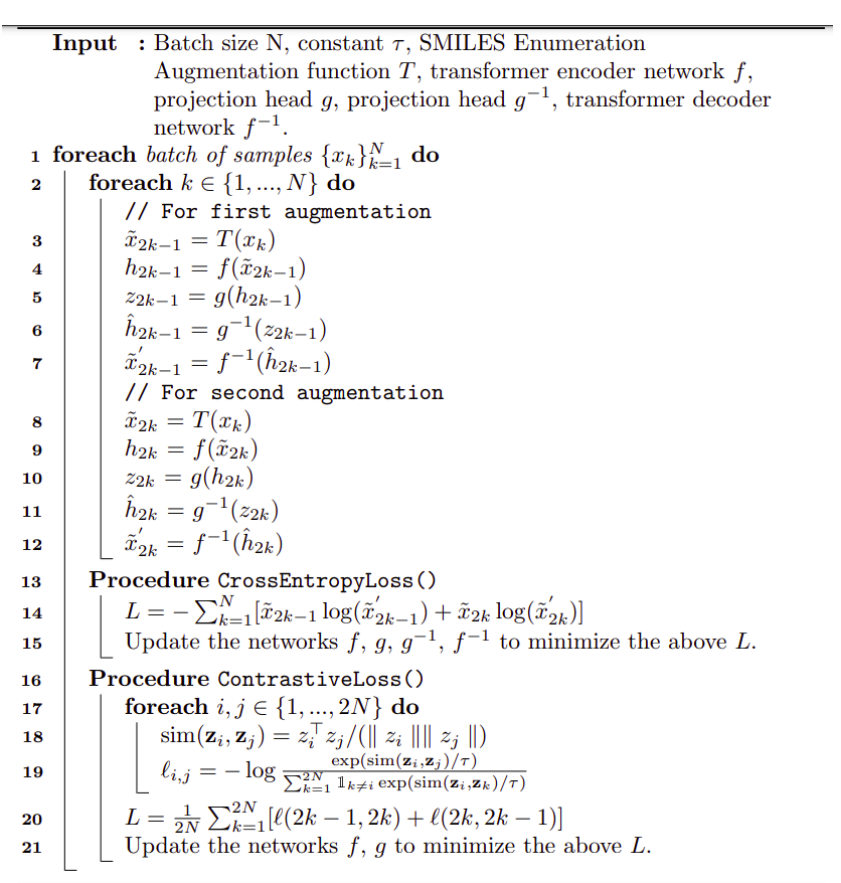
Figure 1. The transformer-based architecture used in the present work. The internals are described in Section 4. Scheme 1. Pseudocode for the transformer algorithm as implemented here.